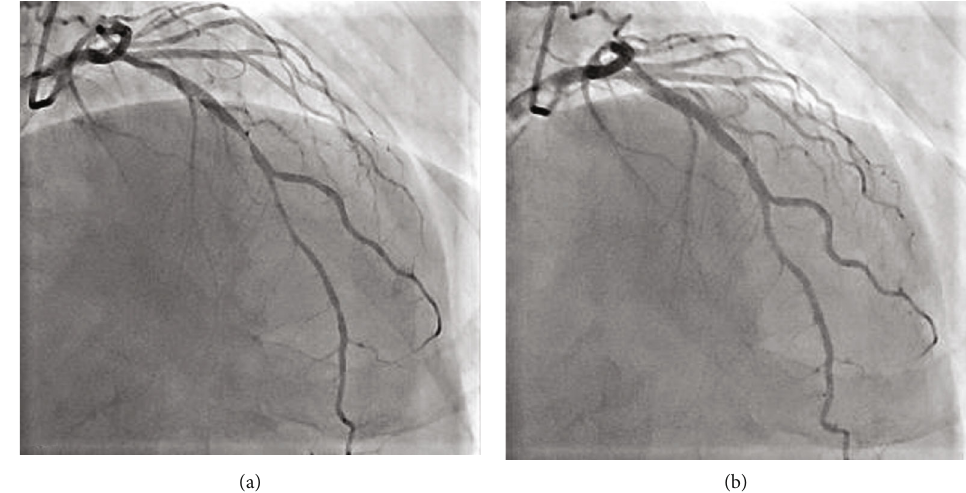
Figure 3: Coronary angiography fi ndings. Left coronary angiography before (a) and after (b) nitroglycerin injection via a catheter, which dilated the stenosis in the middle of the left anterior descending coronary artery.